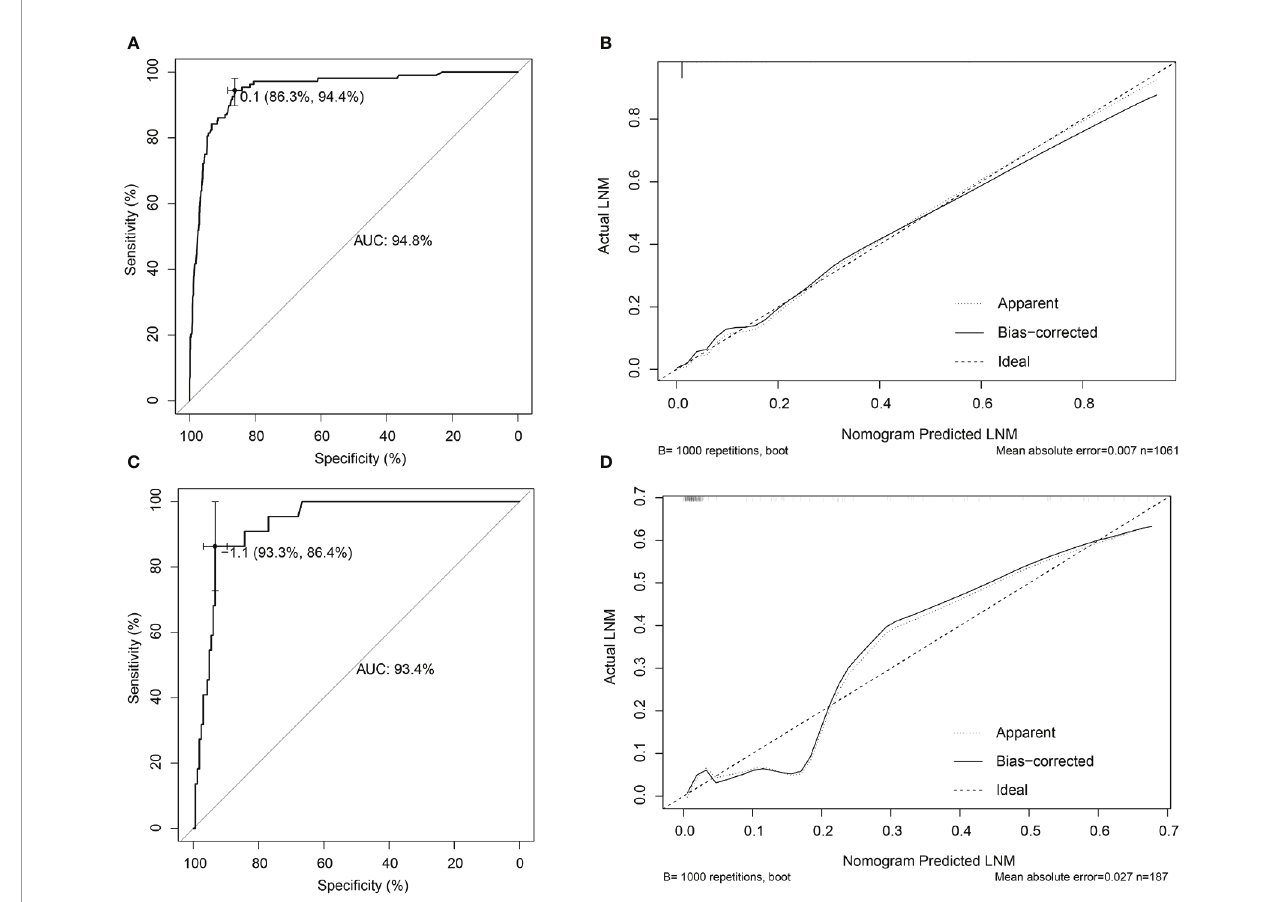
FIGURE 5 | Internal and external validations for the nomogram prediction model in male EGC patients. (A) ROC curve of the nomogram prediction model in the training set of male EGC patients; the AUC was 94.8% (95% CI: 0.9273 – 0.9695). (B) Calibration curve of the nomogram prediction model for the training set of male EGC patients. (C) ROC curve of the nomogram prediction model for male EGC patients in the validation set; the AUC was 93.4% (95% CI: 0.8928 – 0.9755). (D) Calibration curve of the nomogram prediction model in the validation set of male EGC patients. LNM, lymph node metastasis; EGC, early gastric cancer; ROC, receiver operating characteristic; AUC, area under the ROC